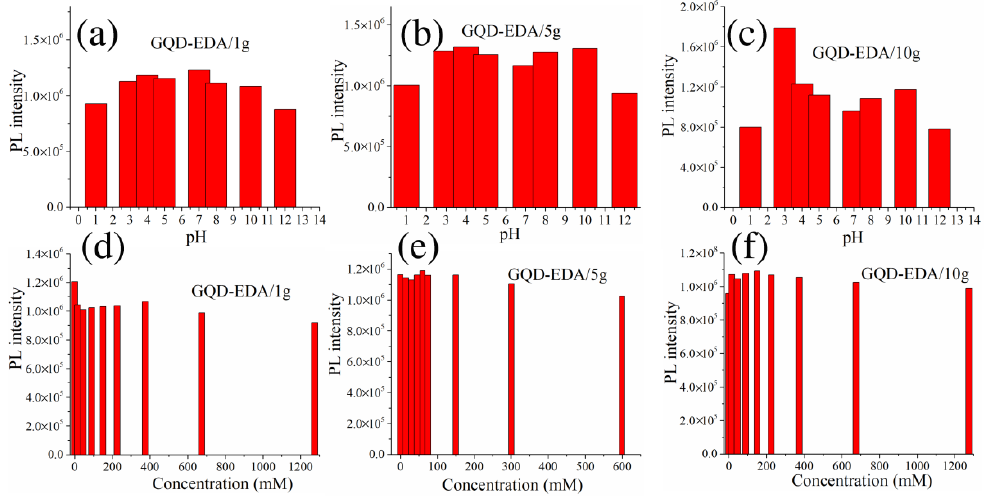
Figure 10. The intensity of the emission bands of the GQDs-EDA/1 g ( a ), GQDs-EDA/5 g ( b ), and GQDs-EDA/10 g ( c ), recorded at λ exc = 360 nm at different pH values and in the presence of the different amount of NaCl, the concentration range 0–1275 mM, ( d – f